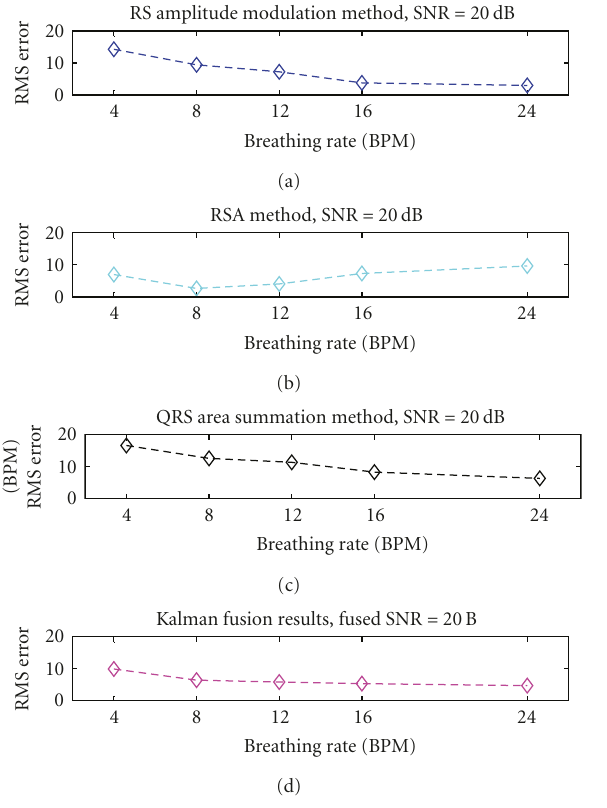
Figure 3: Simulation results at SNR = 20dB. From top to bottom: respiration rates based on RS, RSA, and QRS area-based method, and KF-based fusion results with the purity signal quality index (the fusion 2 algorithm).